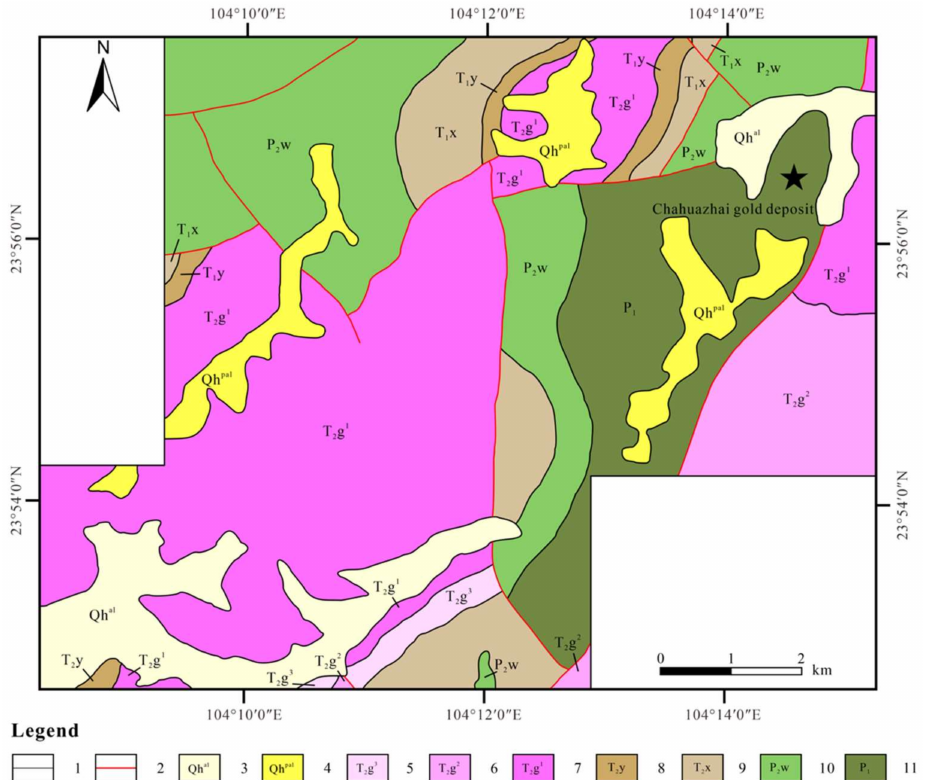
Figure 1. Geological map of Chahuazhai gold mining area. 1 . Geological boundary; 2 . Fault; 3 . Qua- ternary Pleistocene alluvium; 4 . Quaternary Pleistocene flood alluvium; 5 . Third member of Gejiu formation of Middle Triassic; 6 . Second member of Gejiu formation of Middle Triassic; 7 . First member of Gejiu formation of Middle Triassic; 8 . Yongningzhen formation of Lower Triassic; 9 . Ximatang formation of Lower Triassic; 10 . Wujiaping formation of Middle Permian; 11 . Lower